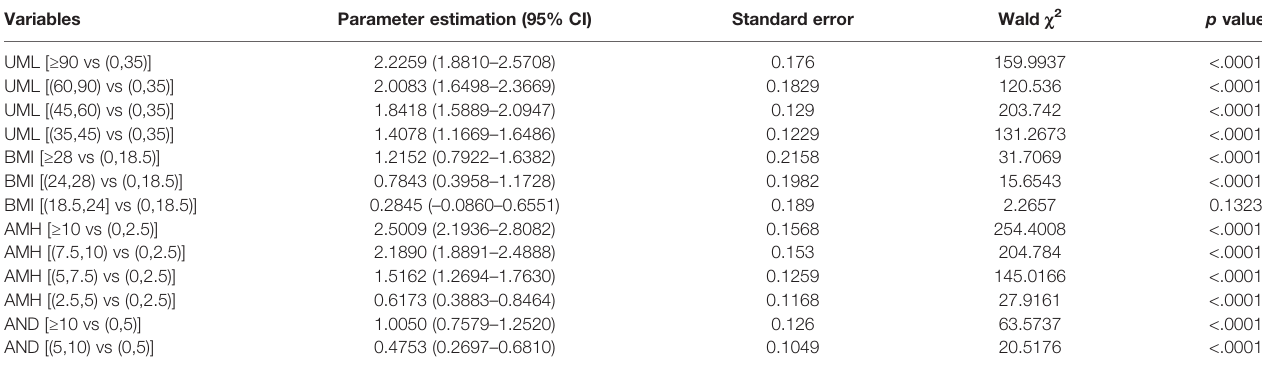
TABLE 4 | Multiple analysis of the effects of each predictive variable on PCOS in Model 3.